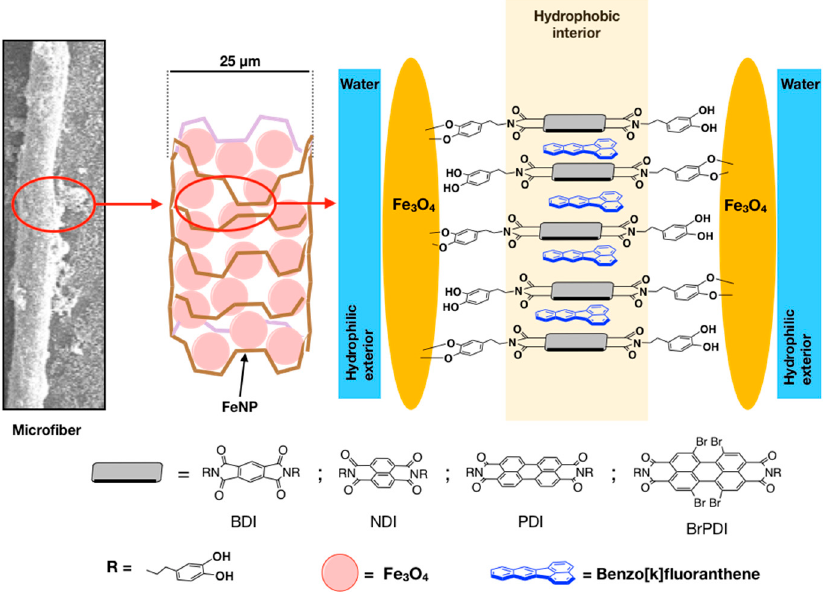
Figure 2. Outline proposed for the formation of microfibres.